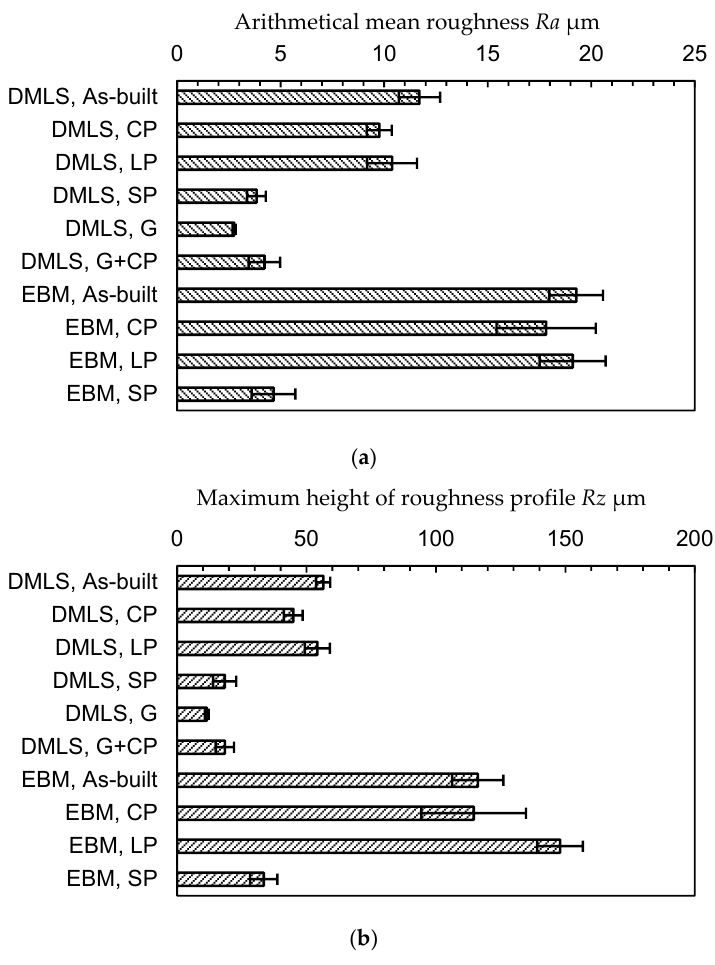
Figure 7. Surface roughness of the as-built Ti6Al4V manufactured by DMLS and EBM and the Ti6Al4V manufactured by DMLS and EBM through cavitation peening (CP), laser peening (LP), shot peeing (SP), grinding (G), and cavitation peening after grinding (G + CP). ( a ) Arithmetical mean roughness Ra . ( b ) Maximum height of the roughness profile Rz.